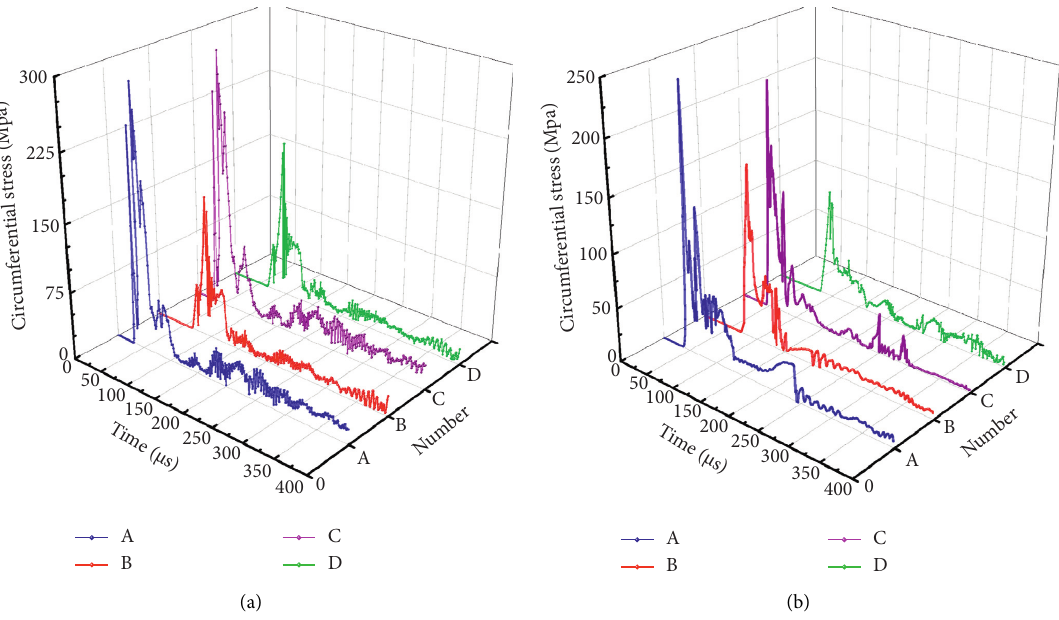
Figure 11: Stress diagram under single-hole load. (a) Ordinary smooth blasting. (b) Shaped